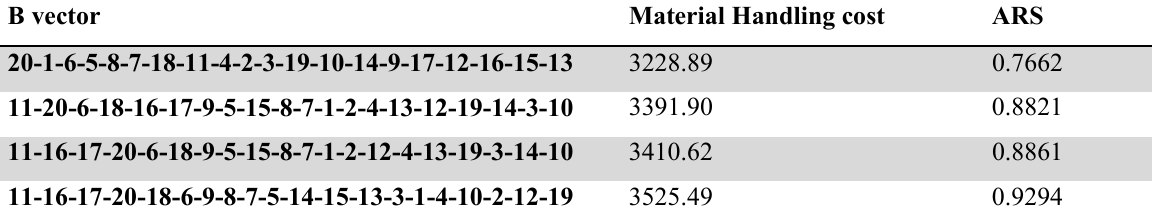
Summary of the best solutions obtained B